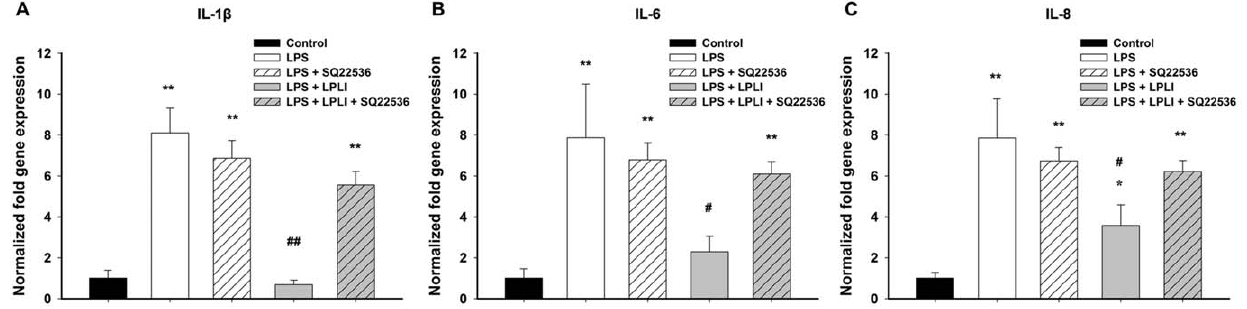
Figure 8. SQ22536 blocks the anti-inflammatory response of LPLI by real-time RT-PCR. ( A ) IL-1 b . ( B ) IL-6. ( C ) IL-8. The results were analyzed by the 2 2 D CT method based on the control. The data are shown as the mean 6 SD (n=6). The following statistical levels were applied: *p , 0.05 and **p , 0.01 compared to the control and # p , 0.05 and ## p , 0.01 compared to LPS (50 ng/ml).